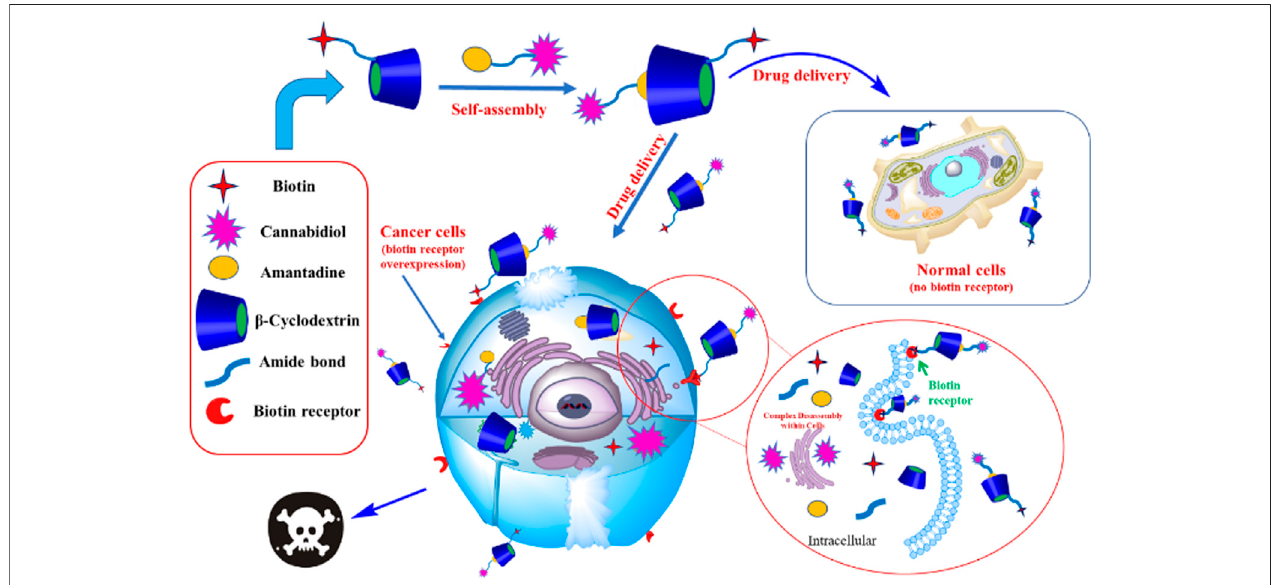
FIGURE 1 | The preparation process of AD-CBD/BIO-CD complex and the mechanism of killing cancer cells.